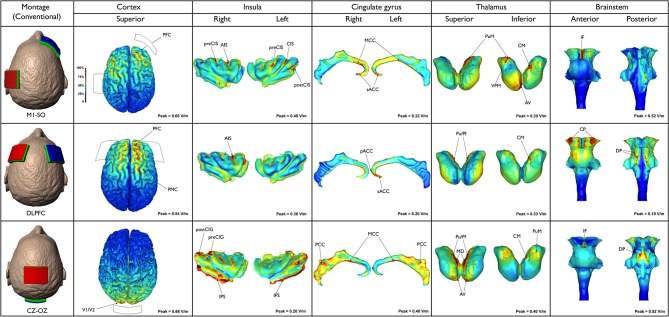
Three different conventional tDCS montages are illustrated (first column, from the top to the bottom): M1-SO motor (cortex-supraorbital), DLPFC (dorsolateral prefrontal cortex bilateral) and Cz-Oz (vertex-occipital cortex). Electric field maps generated in outer cortical regions and inner structures (insula, cingulate gyrus, thalamus and brainstem) are illustrated in the next five columns (from the left to the right).